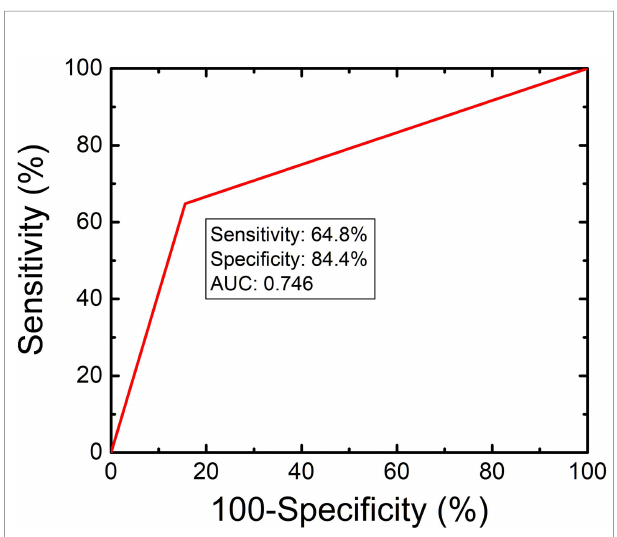
FIGURE 3 | Diagnostic performance of CEUS and CT/MRI LI-RADS in association with serum biomarkers for the diagnosis of